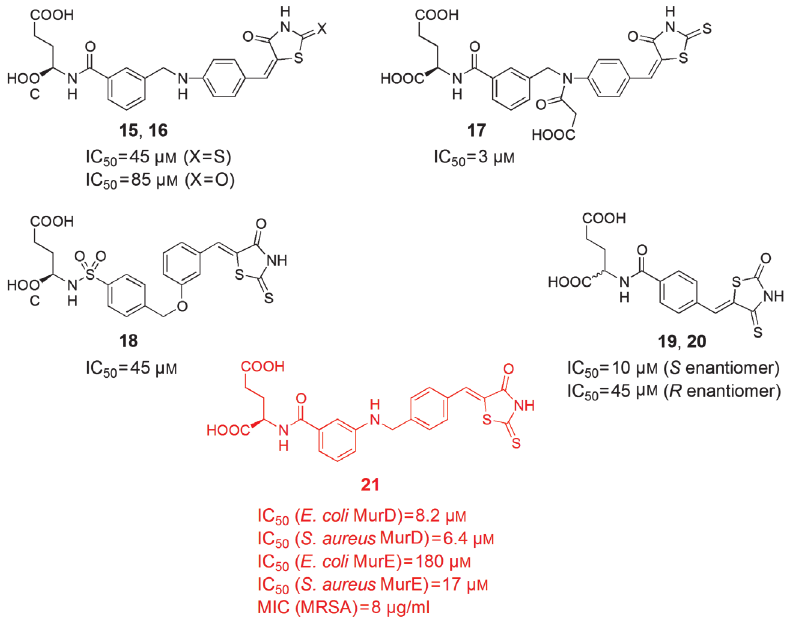
determined with E. coli MurD. Dual MurD and MurE inhibitor 21 is depicted in